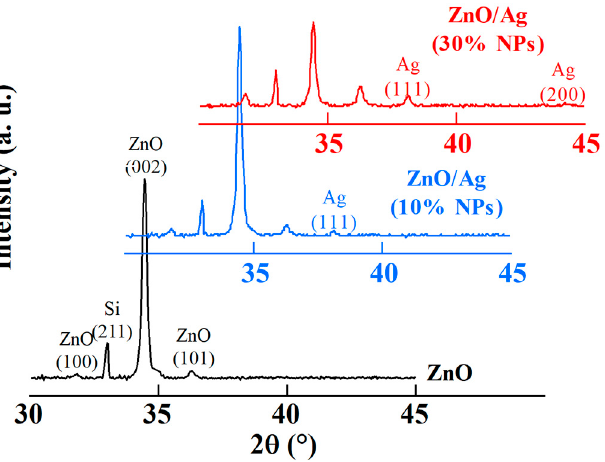
Figure 7. XRD diagram of pure ZnO and ZnO/Ag(NPs) nanocomposites elaborated with contents: 10% and 30% of Ag NPs.